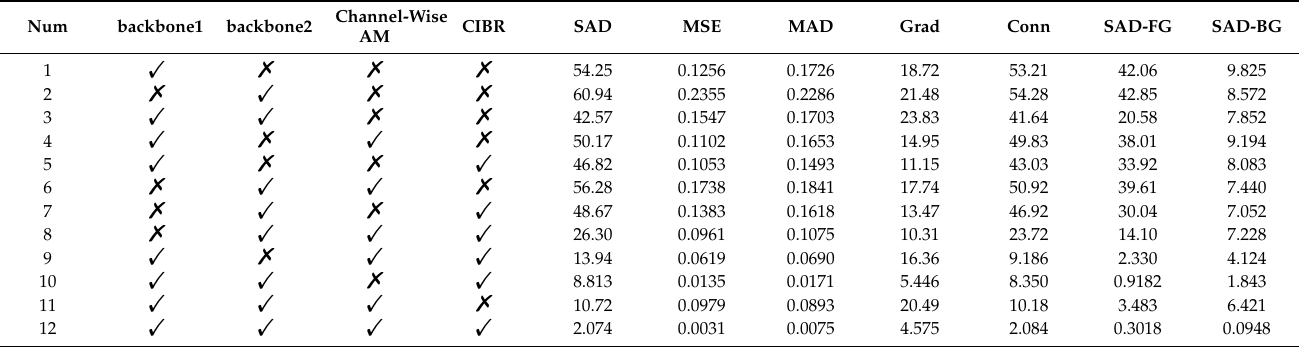
Table 6. The ablation experiment of blocks in the static teacher